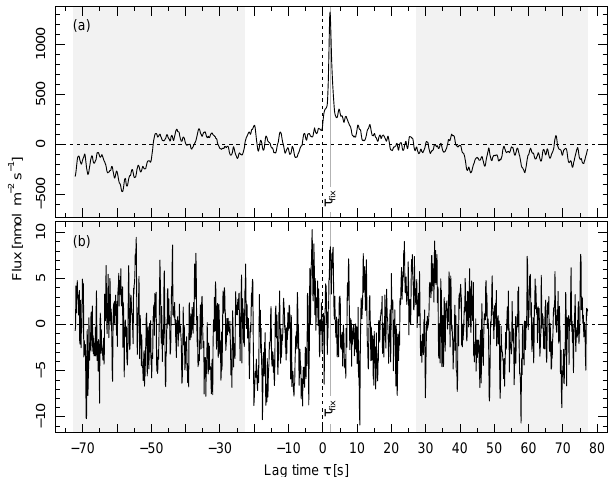
Figure 3. Cross-covariance function of CH 4 fluxes for two 30min intervals of 15 June 2013 (a) with and (b) without cows in the foot- print. The panels correspond to the intervals in Fig. 2. τ fix indicates the expected fixed lag time for the EC system. The gray areas on both sides indicate the ranges used for estimating the flux uncer- tainty and detection